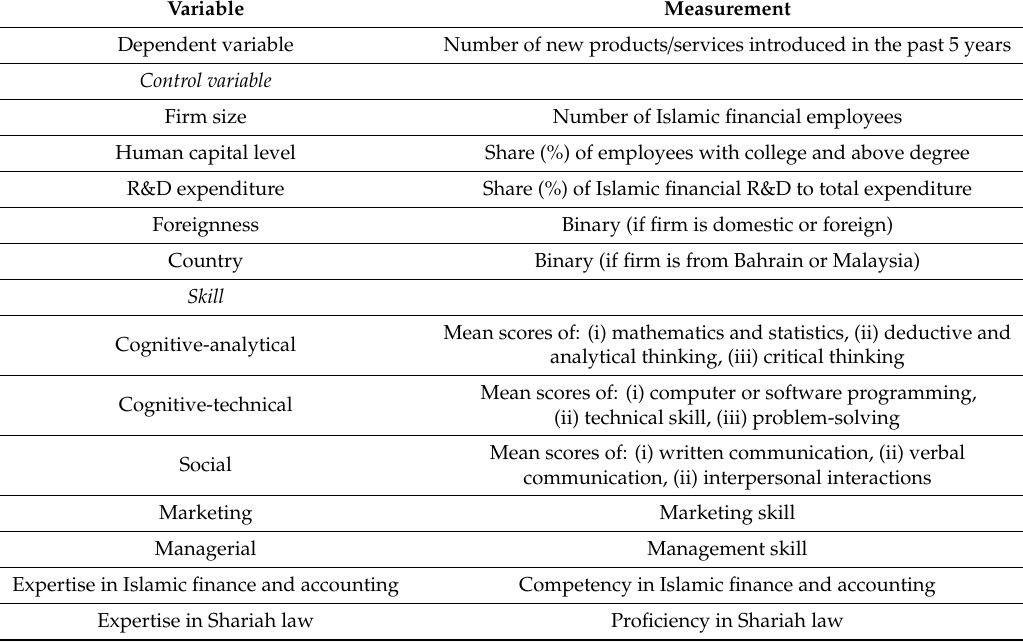
Table A1. Variables and